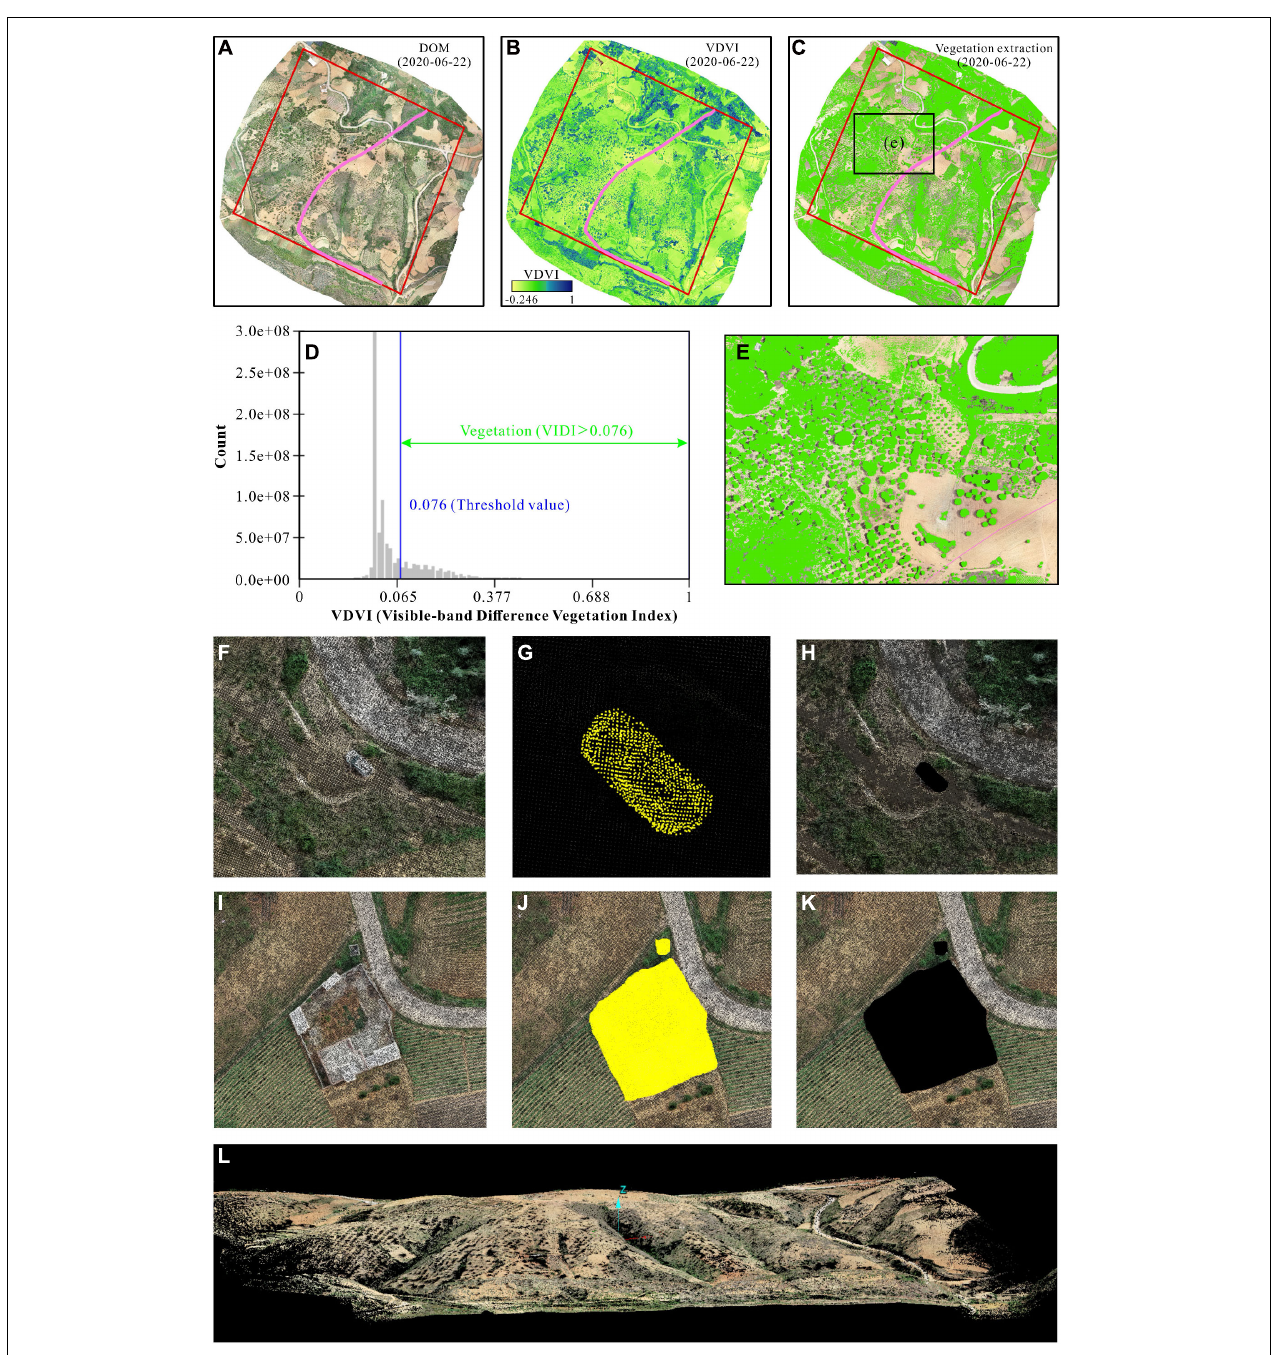
FIGURE 9 | UAV point cloud filtering: (A) DOM, (B) VDVI (Visible-band Difference Vegetation Index) map calculated from the DOM, (C) Vegetation extraction result, (D) Vegetation extraction threshold, (E) Enlarged view of vegetation extraction, (F–H) Car point clouds filtering, (I–K) Building point clouds filtering, and (L) Topographic point clouds after vegetation filtering.